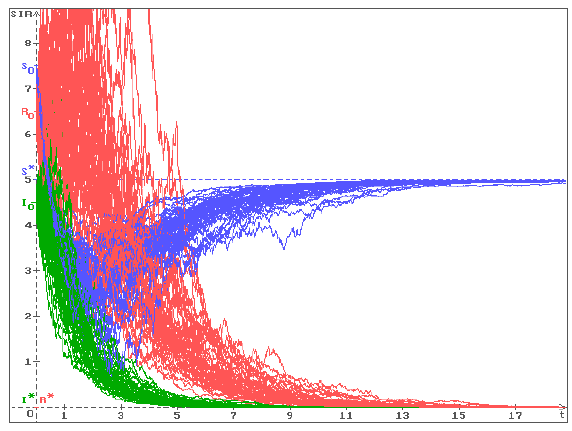
Figure 5. Fifty trajectories of the solution of the system (6) solution: S ( t ) (blue), I ( t ) (green), R ( t ) (red) with the initial values S ( 0 ) = 7.5, I ( s ) = 4.5, s ∈ [ − h ,0 ] , R ( 0 ) = 6.5 and δ 1 = 0.39, δ 2 = 0.49, δ 3 = 0.49, h = 0.1.